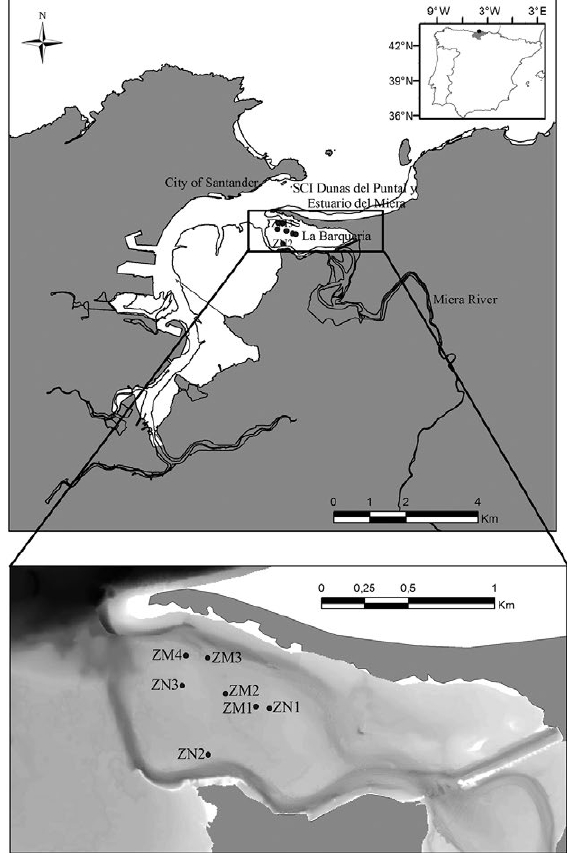
Fig. 1. – Location of the study area and sampling sites in the Bay of Santander for Zostera marina (ZM1-ZM4) and Zostera noltei (ZN1-ZN3). The study area is delimited within the